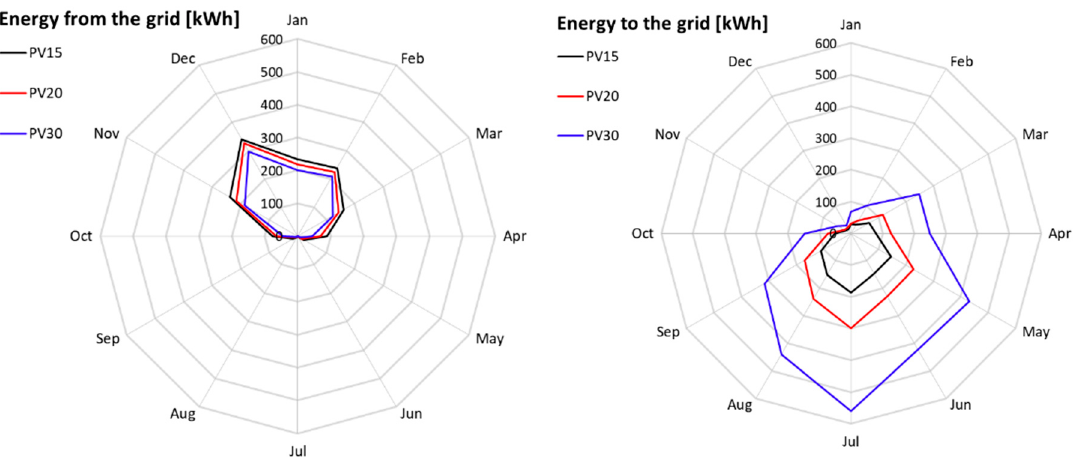
Figure 7. Monthly energy exchanges with the grid for the case with control strategy HP+ and EH+, and for a PV area of 15, 20, and 30 m 2 .